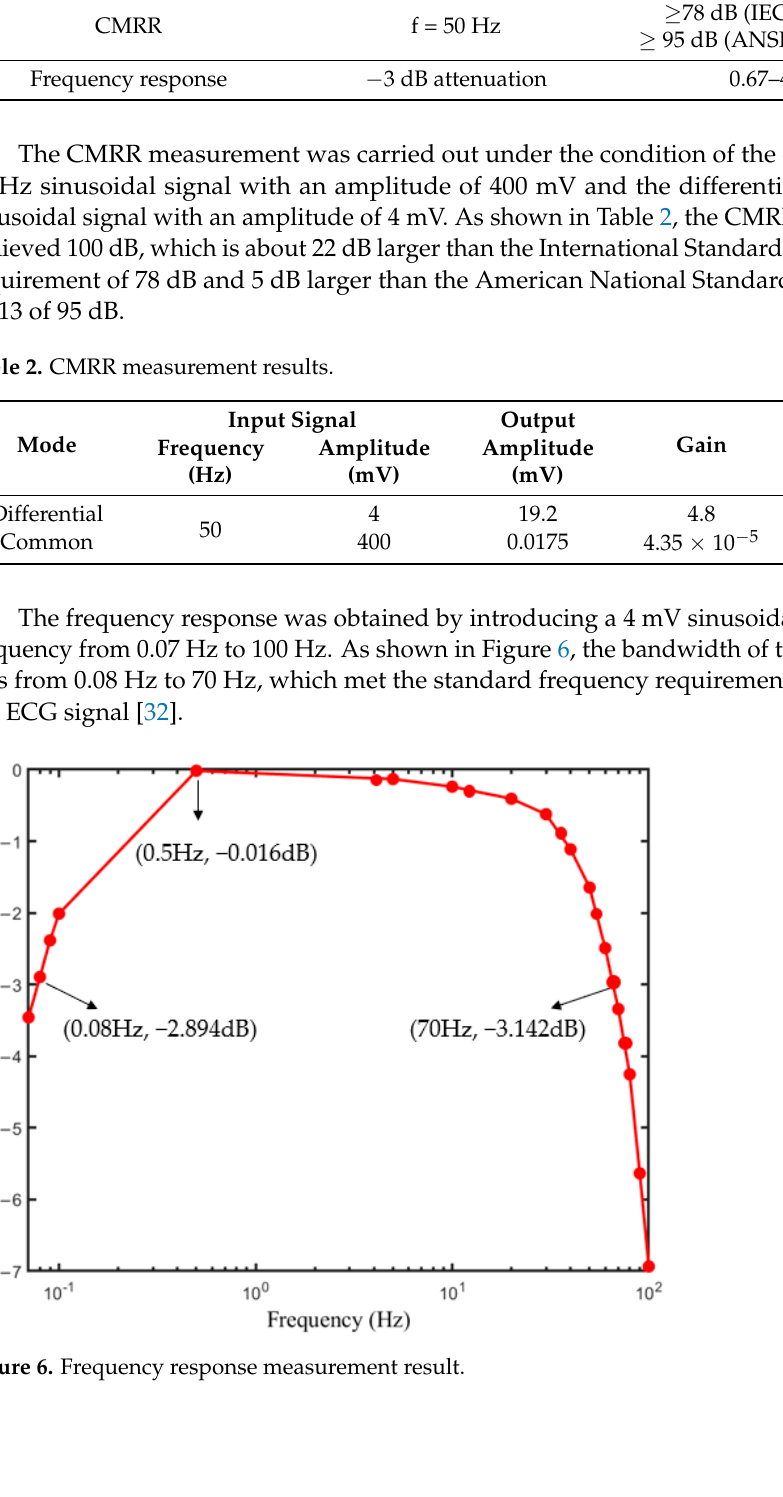
Figure 7. The input ‐ referred voltage noise density. 4. Experimental Results In this experiment, the experimental system was connected to a bandage with the snap fasteners, as shown in Figure 8a. Two sets of conductive silver fabric electrodes were stitched to the bandage. The reference signal acquisition electrodes were comb ‐ tooth shaped, and the size of each comb tooth was 0.5 cm × 3 cm, as shown in Figure 8b. The ECG signal acquisition electrodes were rectangular electrodes with an electrode size of 6 cm x 3 cm, as shown in Figure 8c. The two types of electrodes were fixed and isolated from